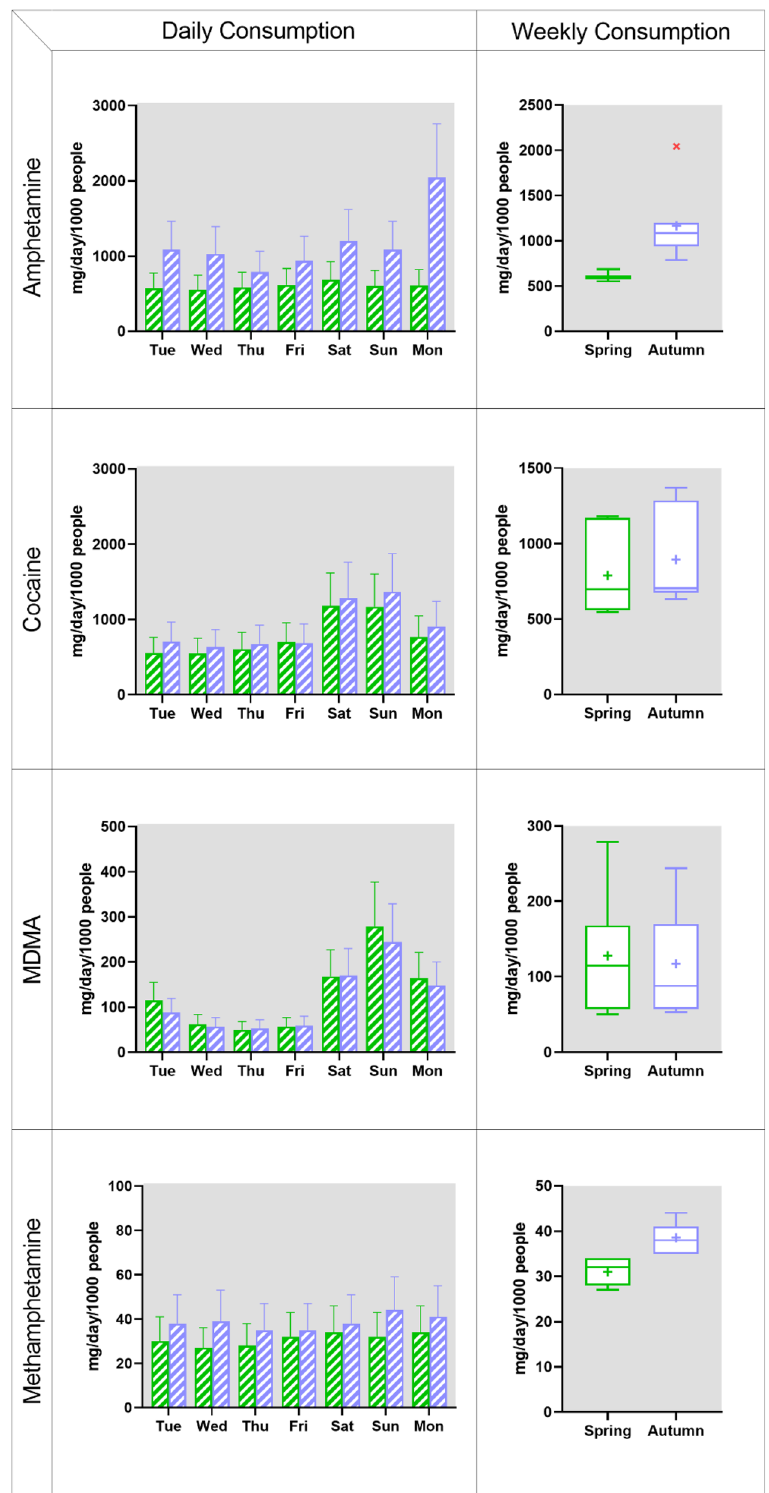
Figure 2. Day-to-day (bar chart) and weekly (Tukey box-and-whisker plot) drug consumption in Stockholm in two studied periods (green: campaign 1 in spring; purple: campaign 2 in autumn). Error bars taken in account the uncertainty of sampling, chemical analysis, flow measurement, excretion fraction and population as previously described 21,36,46 . In the box plot (see “Methods” for details), a red cross indicates an outlier and + represents an average